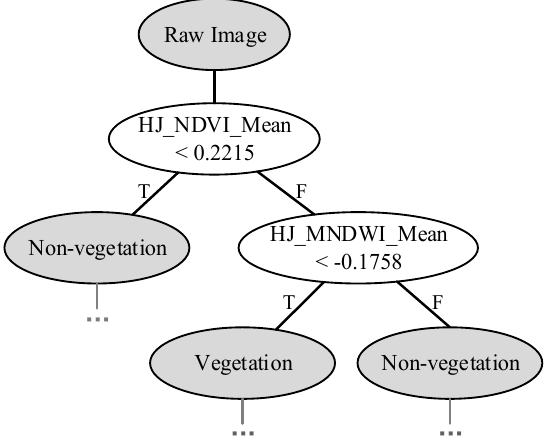
Figure 6. The decision tree for distinguishing vegetation and non-vegetation. The HJ-CCD image acquired on 24 July 2010. The ellipsis represents the land cover class needed for further division.